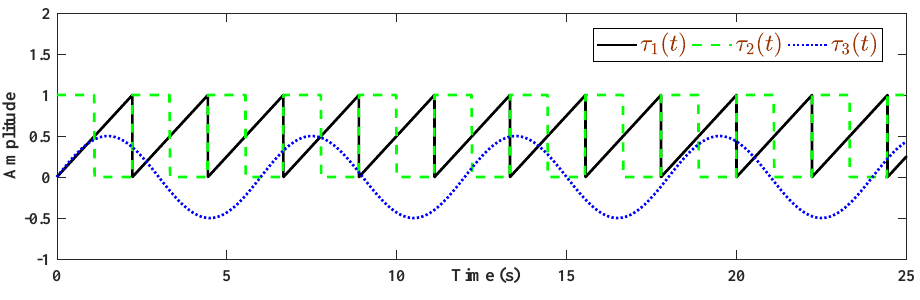
Figure 2. System delays related to Scenario